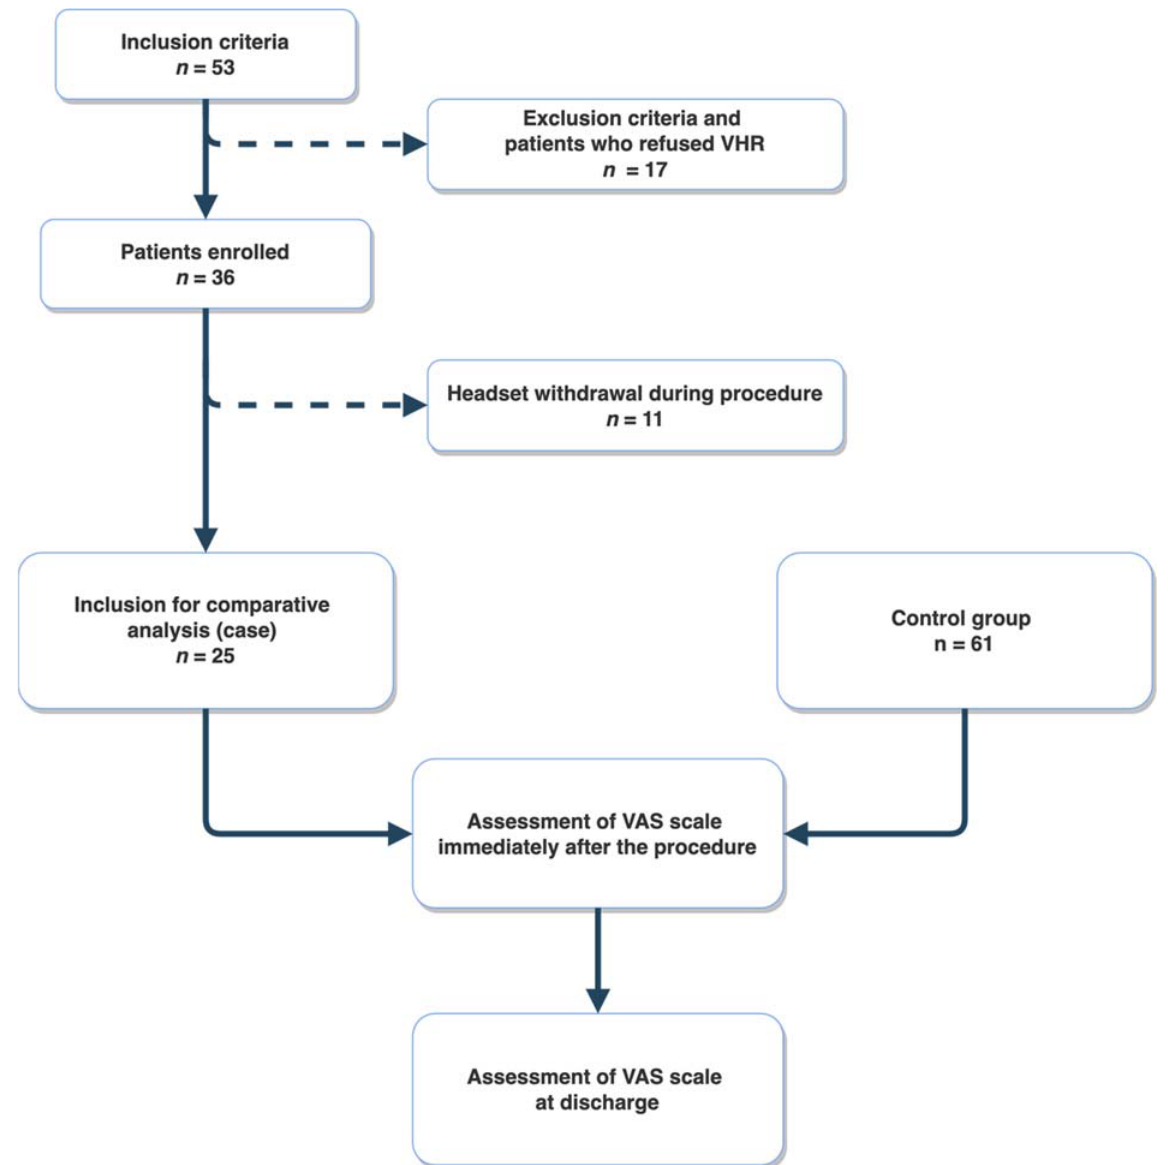
Figure 1. Flow chart of the study. VRH: virtual reality hypnosis. VAS: Visual Analogue Scale.